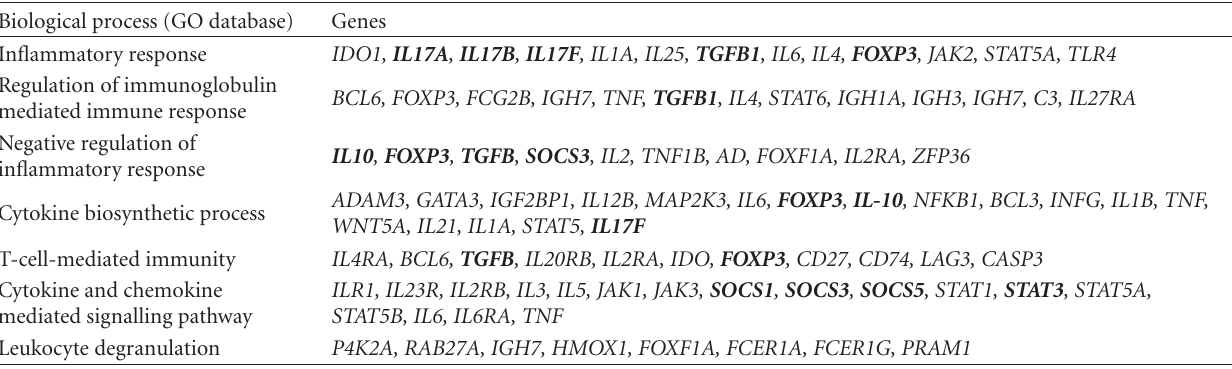
Table 1: Genes included in upregulated gene ontology pathways in OVA versus pEGFP-GAL 3 comparison. Biological process (GO